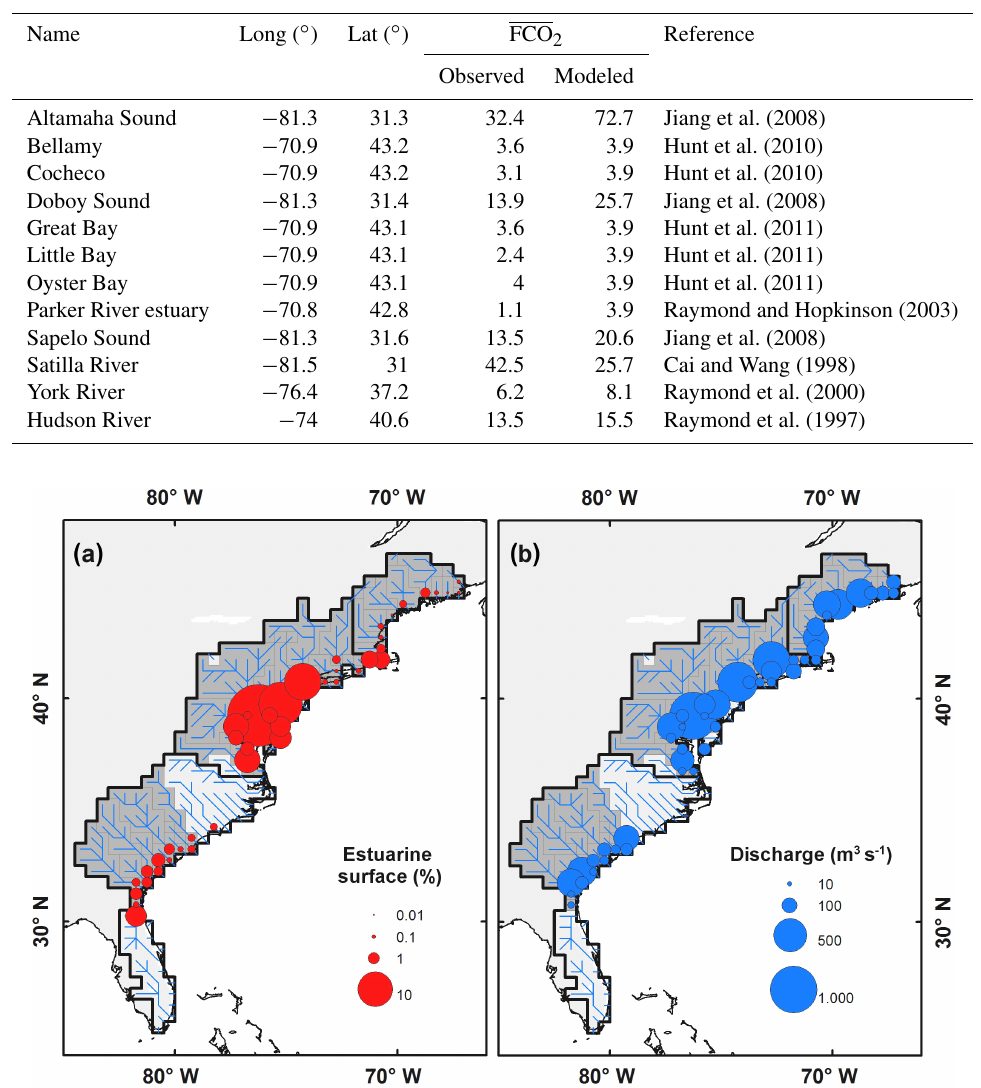
Figure 3. Estuarine surface area (a) and mean annual freshwater discharge (b) for each tidal estuary of the US East Coast. Estuarine surface area is expressed as a percentage of the entire surface area of the region (19830km 2 )